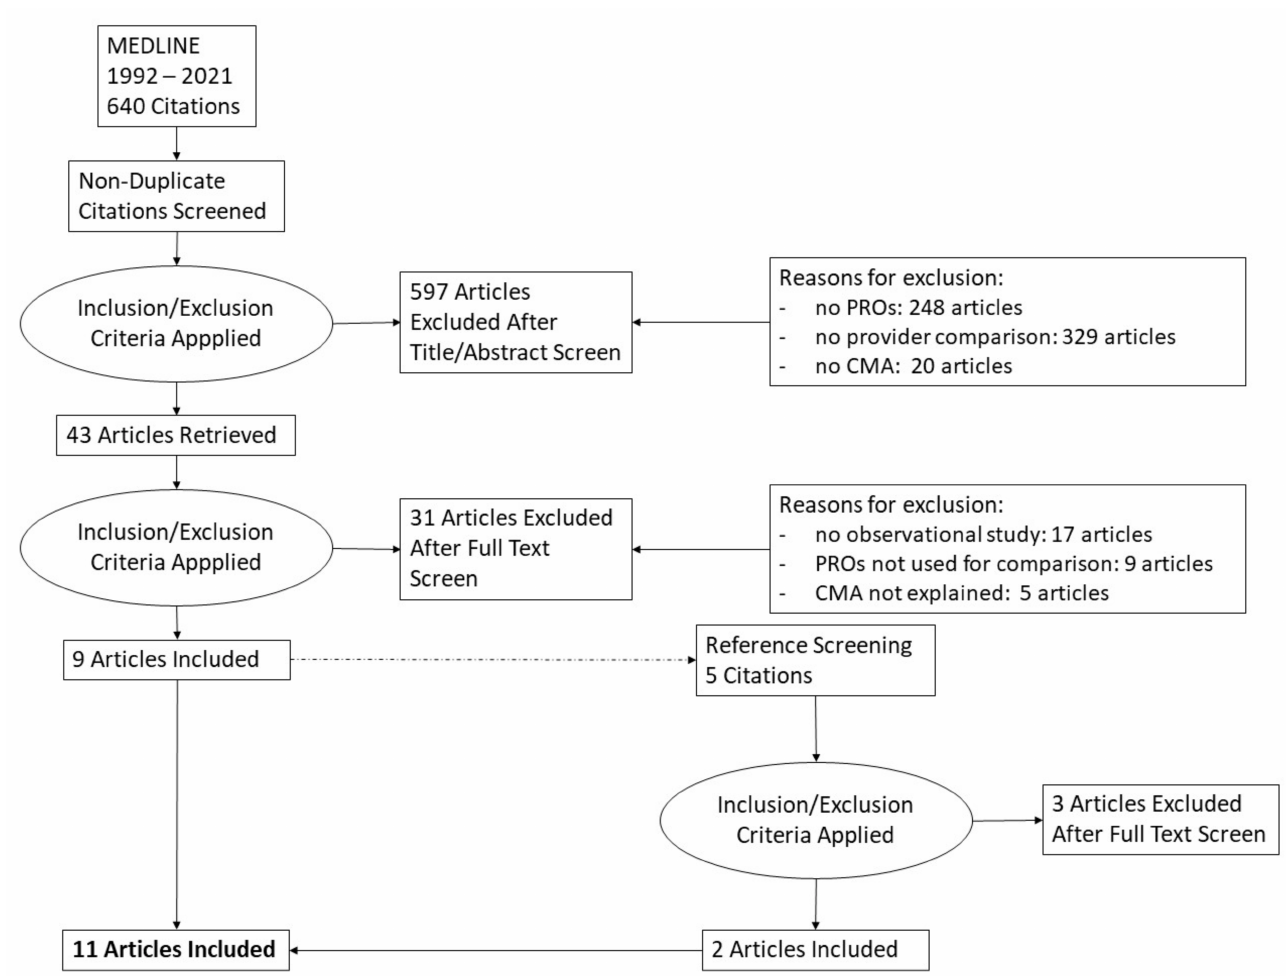
Figure 1. PRISMA flowchart. PRO, patient-reported outcome; CMA, case-mix